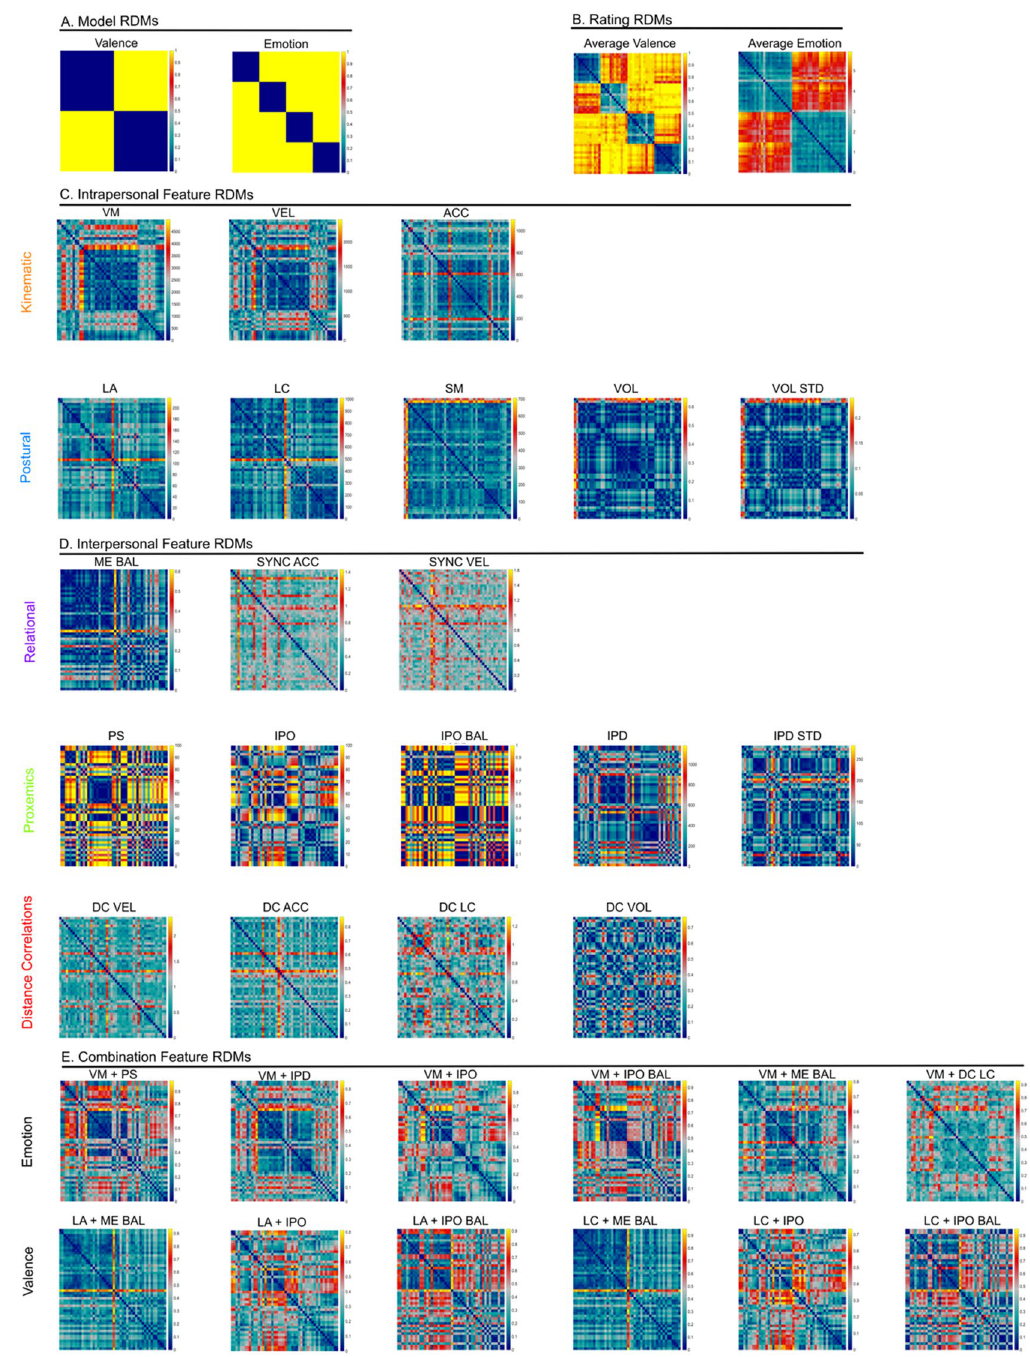
Figure 3. Representational dissimilarity matrices. ( A ) Theoretical model RDMs that assume different similarities based on emotion and valence categories (0 if identical, 1 otherwise). ( B ) Behavioural, averaged over participants emotion (1 if correct, 0 otherwise) and valence rating RDMs (Euclidean distance as similiarity measure). RDMs for ( C ) intrapersonal features, ( D ) interpersonal features and ( E ) combination features using Euclidean distance as similarity measure. LA limb angles, LC limb contraction, SM symmetry, VEL velocity, ACC acceleration, VM vertical movement, VOL volume, VOL STD volume standard deviation, DC VEL distance correlation velocity, DC ACC distance correlation acceleration, DC L C distance correlation limb contraction, DC VOL distance correlation volume, IPD interpersonal distance, IPD STD interpersonal distance standard deviation, IPO interpersonal orientation, IPO BAL interpersonal orientation balance, ME BAL motion energy balance, PS personal space, SYNC VEL synchronization velocity, SYNC ACC synchronization